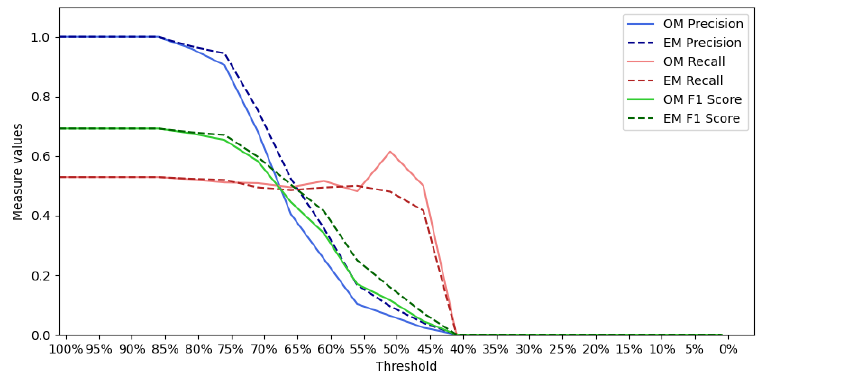
Figure 11. Results of the event “Putin